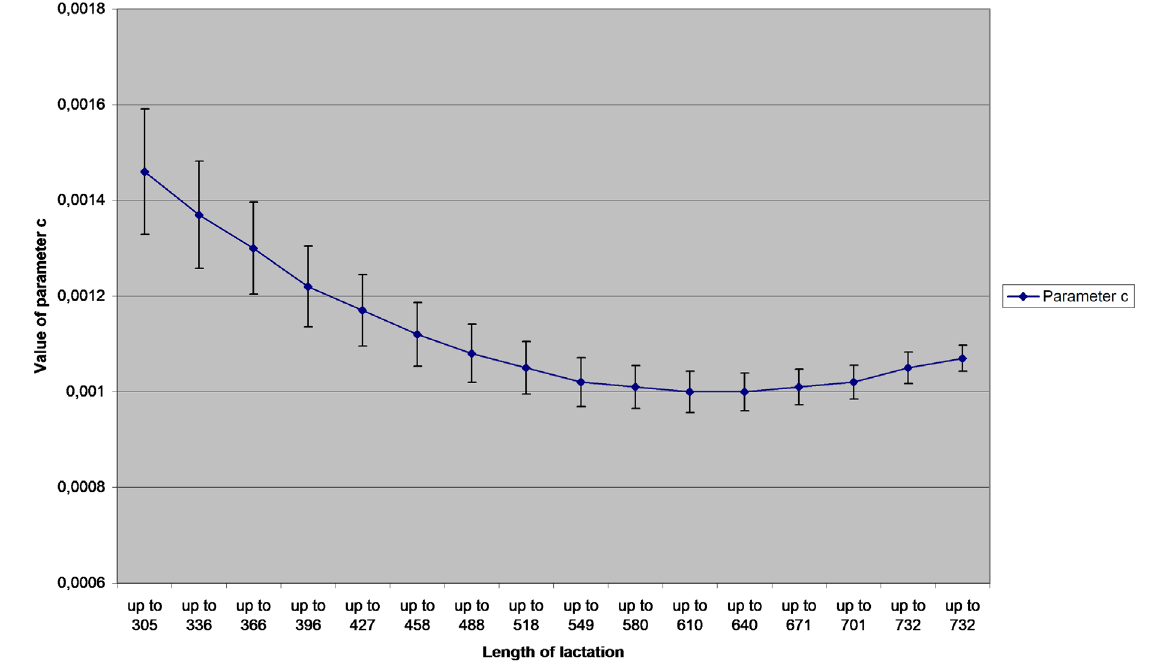
Figure 3. Mean values and their standard errors (+/– 2.96 standard error) of the assessed parameter c of Wood’s model for different lengths of lactation (in